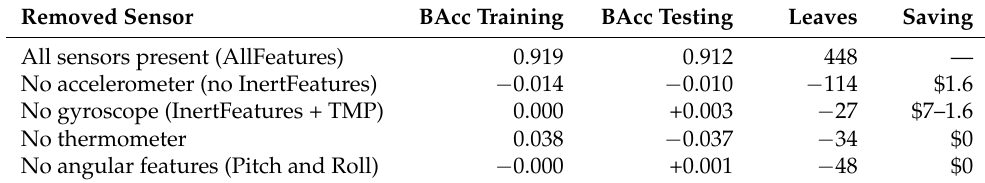
Table 6. Balanced accuracies by sensor.